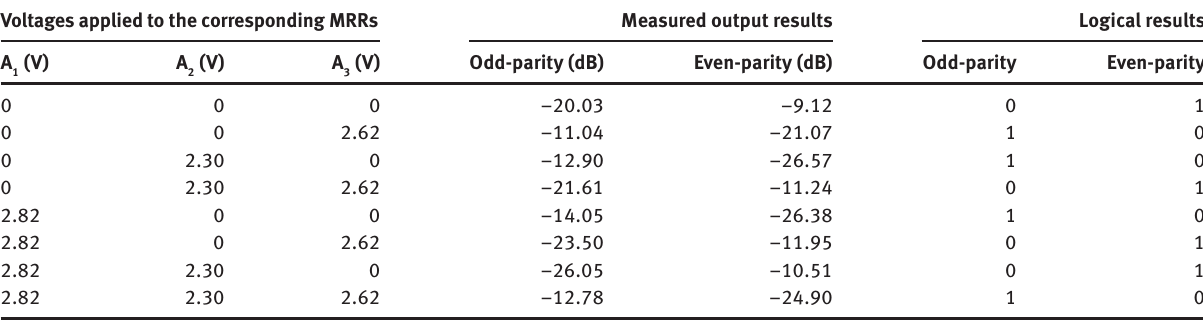
Table 2: Measured truth table of the proposed 3-bit optical parity checker. Voltages applied to the corresponding